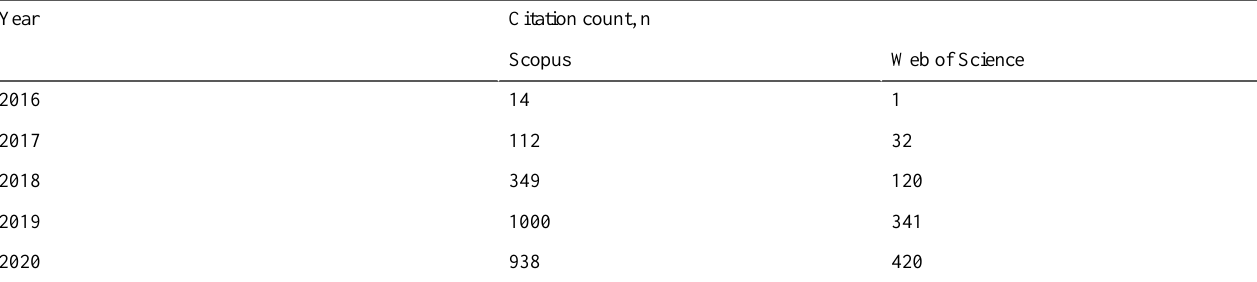
Table 7. Number of citations per year.